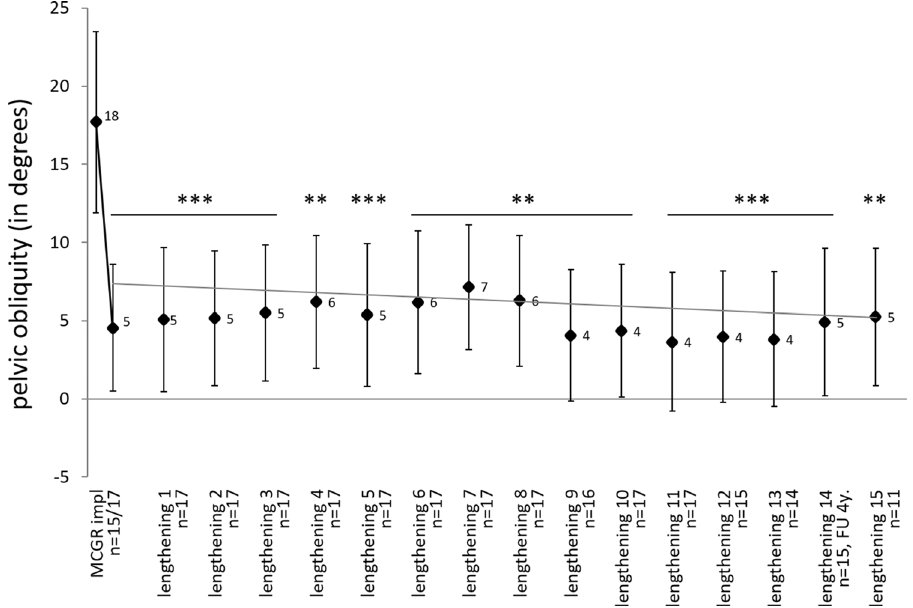
Figure 3. Development of the pelvic obliquity (mean ± standard error, in degrees) before and after MCGR implantation and after every lengthening procedure with n > 10. Significance (** p < 0.01, *** p < 0.001) between the time points and the initial value was evaluated with paired Student’s t-test. The regression line is drawn for all values post implantation.